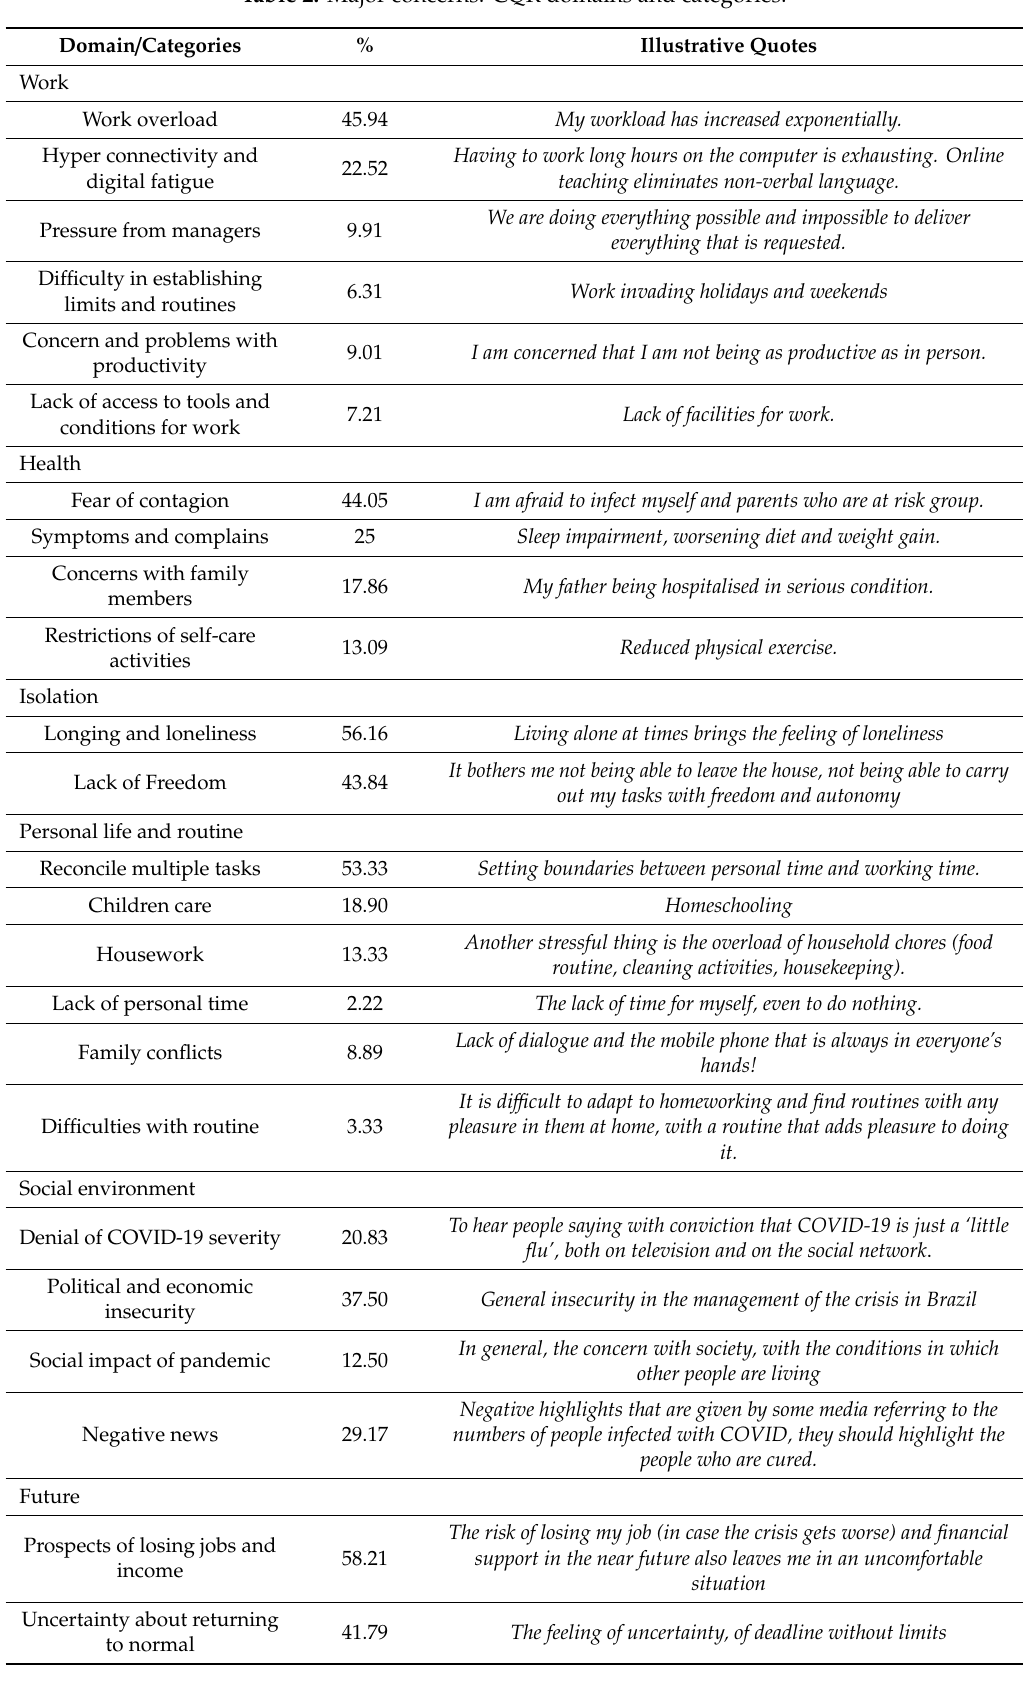
Table 2. Major concerns: CQR domains and